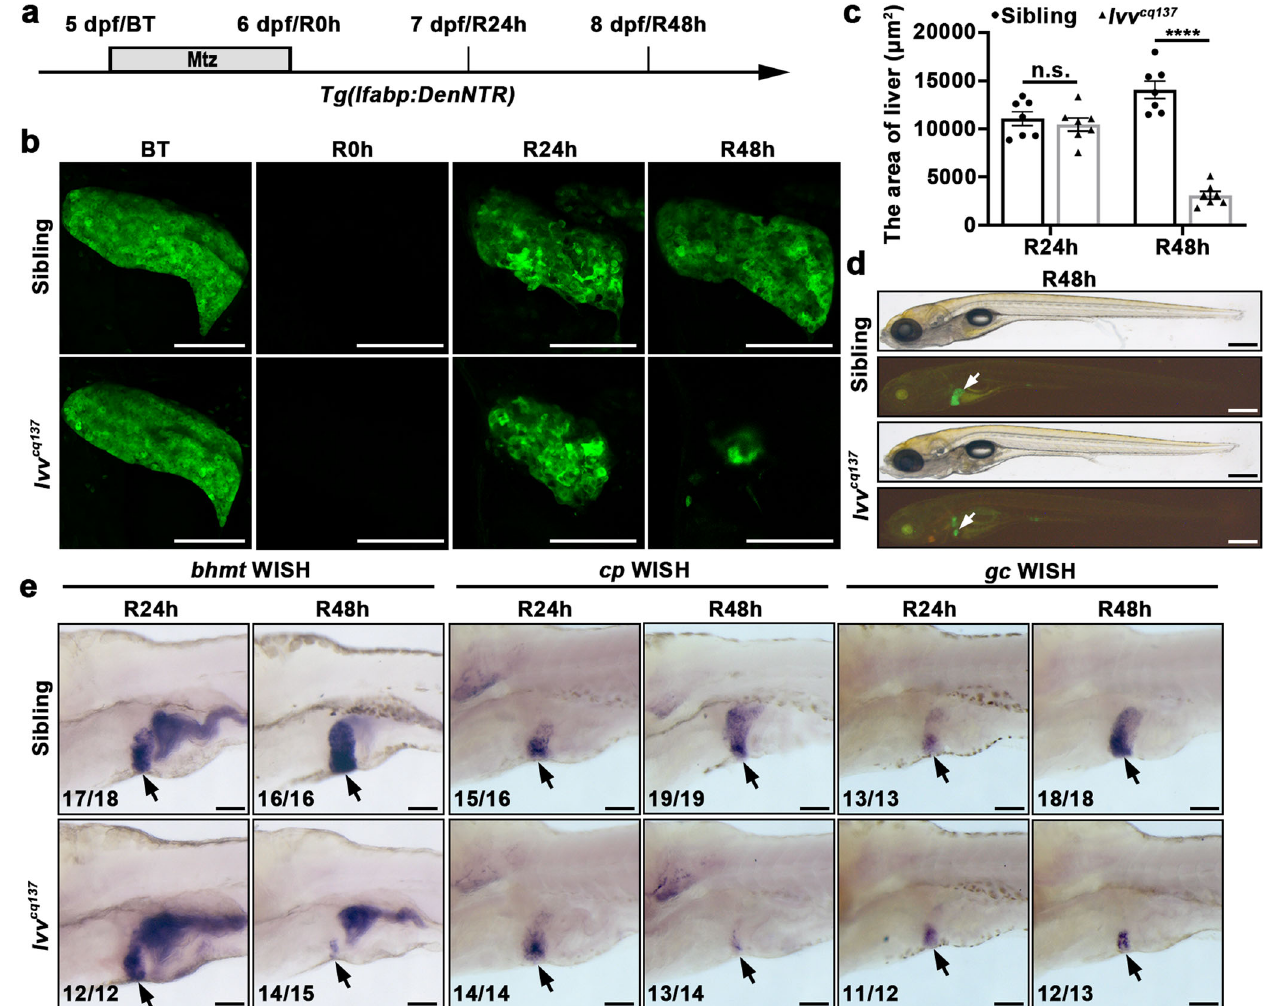
Fig. 1 The maintenance of nascent hepatocytes is defective in lvv mutant in liver regeneration. a Schematic illustration of Mtz treatment and analysis at BT (5 dpf), R0h (6 dpf), R24h (7 dpf), and R48h (8 dpf). b Confocal projection images showing the regenerating livers of sibling and lvv mutant from BT to R48h under the Tg(lfabp:DenNTR) background. c Quanti fi cation of the area of liver sizes, n = 7 larvae per group. d Bright- fi eld and epi fl uorescence images showing the morphological appearance and regenerating livers (arrows) of sibling and lvv larvae at R48h, respectively. e WISH images showing the expressions of bhmt , cp , and gc in regenerating livers (arrows) at R24h and R48h in sibling and lvv larvae. Asterisks indicate statistical signi fi cance: **** P < 0.0001 using t -tests analysis when compared to control. Numbers indicate the proportion of larvae exhibiting the phenotype shown. Scale bars, 100 μ m b , e , and 300 μ m d ; error bars, ±SEM. BT before Mtz treatment, R regeneration time after the withdrawal of Mtz, WISH whole-mount in situ hybridization, n.s. no signi fi